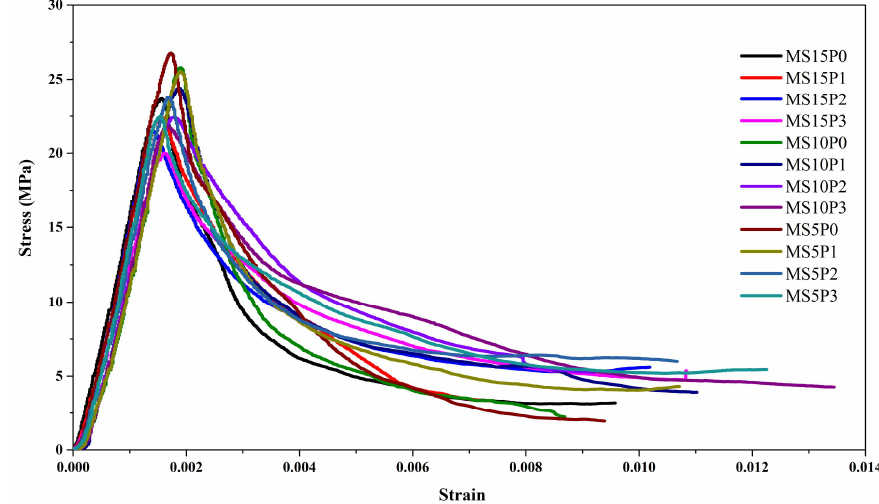
Figure 21. Stress–strain behavior of the MS samples .